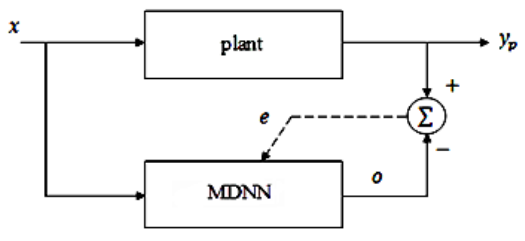
Figure 2. Modified dynamic neural network as the identifier.